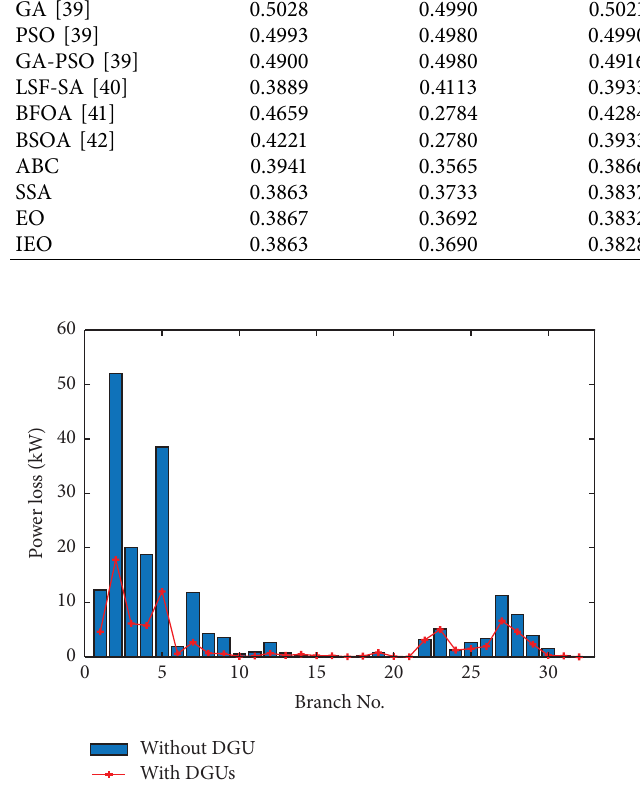
Figure 8: Power loss on distribution lines in IEEE 33-bus radial distribution system before and after placing